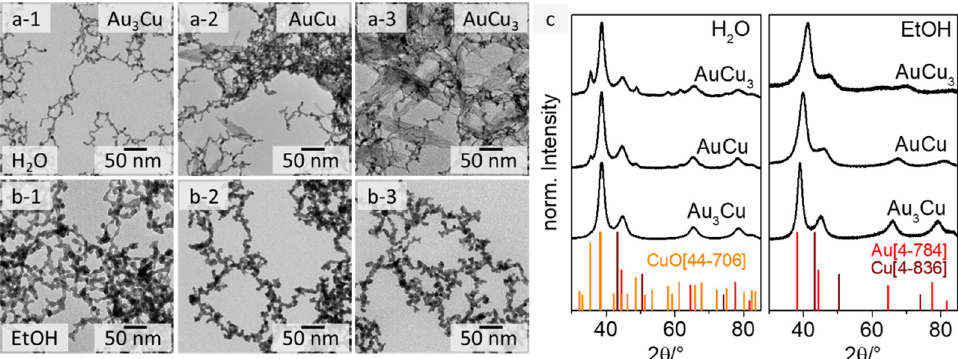
Figure 1. TEM images of Au 3 Cu ( 1 ), AuCu ( 2 ), and AuCu 3 ( 3 ) aerogels from an aqueous synthesis ( a ) with an occurring needle-shape side phase for the Cu-rich compositions and from an ethanolic synthesis ( b ) without side phase. XRD analysis ( c ) shows the crystalline structure of the Au x Cu y gels and additional Bragg reflections of CuO for the gels from the aqueous approach.